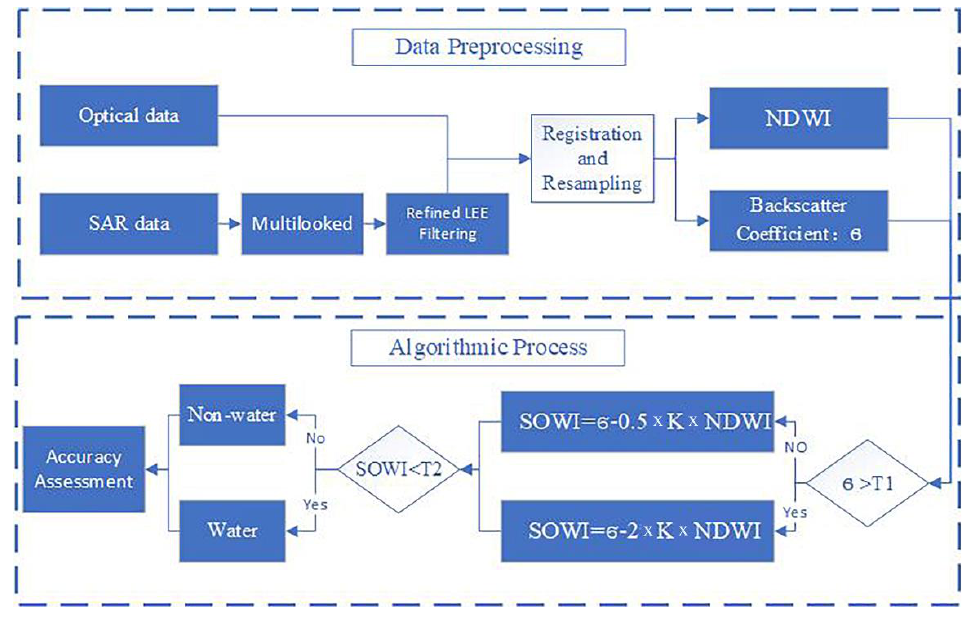
Figure 2. Overview of the application of the fusion algorithm SOWI based on two different satellite images, that is, optical and synthetic aperture radar (SAR) images.